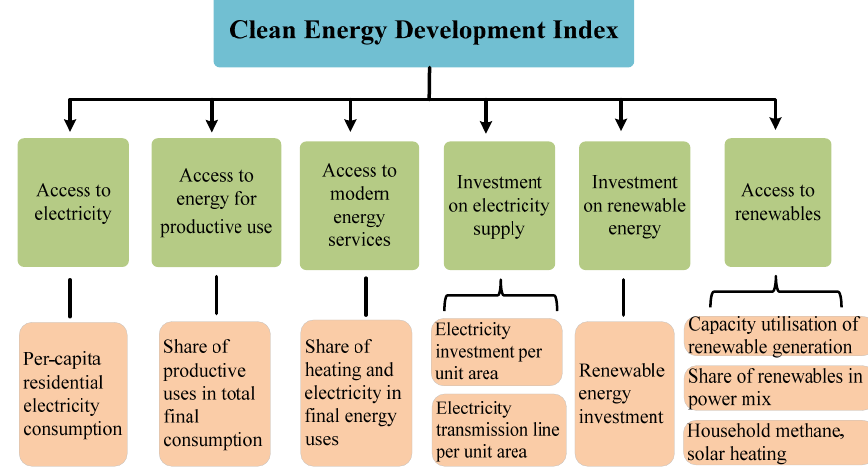
Figure 1. Framework for clean energy development index.